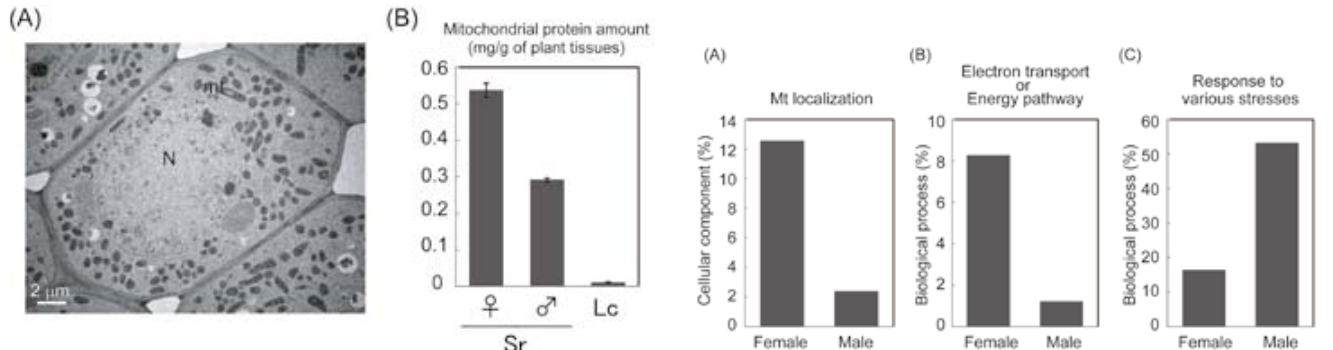
Fig. 3 - Examples of transcriptional changes of cellular components and biological processes of female- and male-stage spadices of S. renifolius . Genes encoding proteins localized in mitochondria (A) or that play roles in electron transport or the energy pathway (B) are highly expressed at the female stage, but not at the male stage of floral development. Genes encoding stress-responsive proteins (C) were highly expressed at the male stage, but not at the female stage. (A) was partially extracted from figure 3a (the cellular component data) in our previous paper (Ito-Inaba et al ., 2012 a). (B) and (C) were also partially extracted from figure 3b (the biological process data) in the same